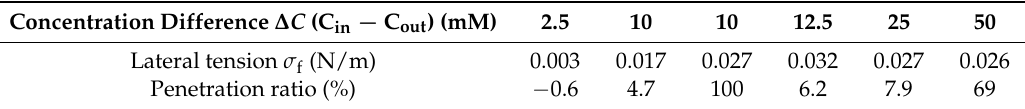
Table 1. Relationship between the final lateral tension and penetration